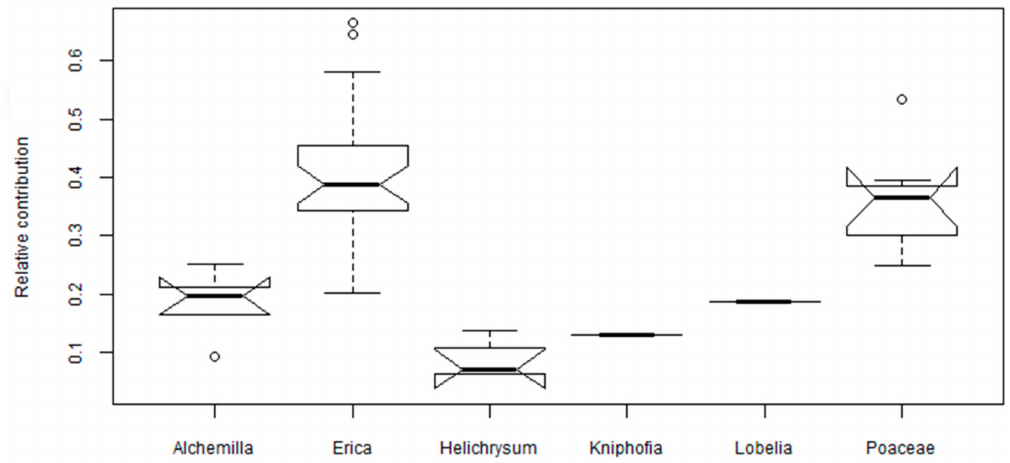
Figure 2. Notched box plots illustrating the abundance of coumaryl phenols in the dominant plant species of the Bale Mountains. The box plots indicate the median (solid line between the boxes), interquartile range (IQR) with upper (75%) and lower (25%) quartiles and possible outlier (white circles). The notches display the confidence interval around the median within +/ − 1.57 * IQR /